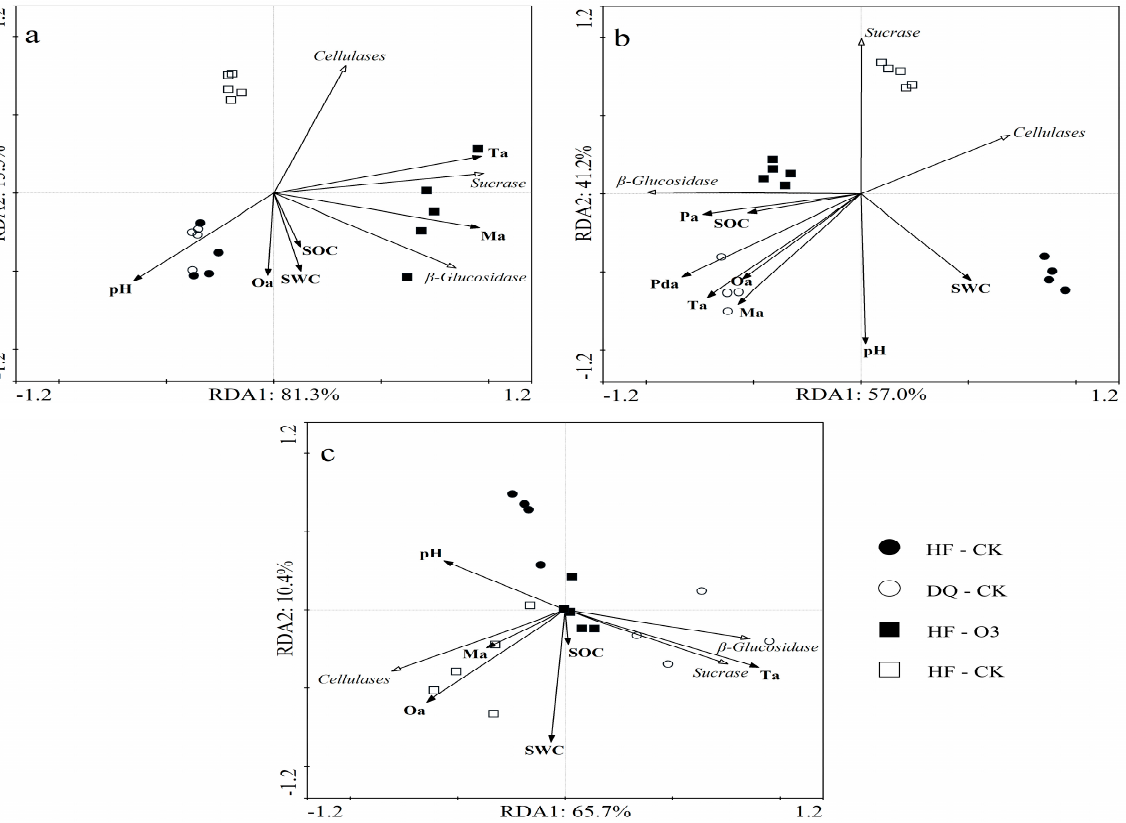
Figure 4. Redundancy analysis (RDA) of C-transforming enzymes, organic acid, and environmental factors at seedling ( a ), flower ( b ) and maturity( c ) stages. The meaning of environmental factor representatives is consistent with the above figure. solid and hollow represent the treatment under HF and DQ varieties, respectively. DQ represents low soil nutrient tolerant variety and HF represents low soil nutrient sensitive variety. circle and square represent CK and O3 treatments, respectively. Pda, malonic acid; Pa, propionic acid; Oa, oxalic acid; Ta, tartaric acid; Ma, malic acid; BG, β − glucosidase; SC, sucrase enzyme; CE, celluase